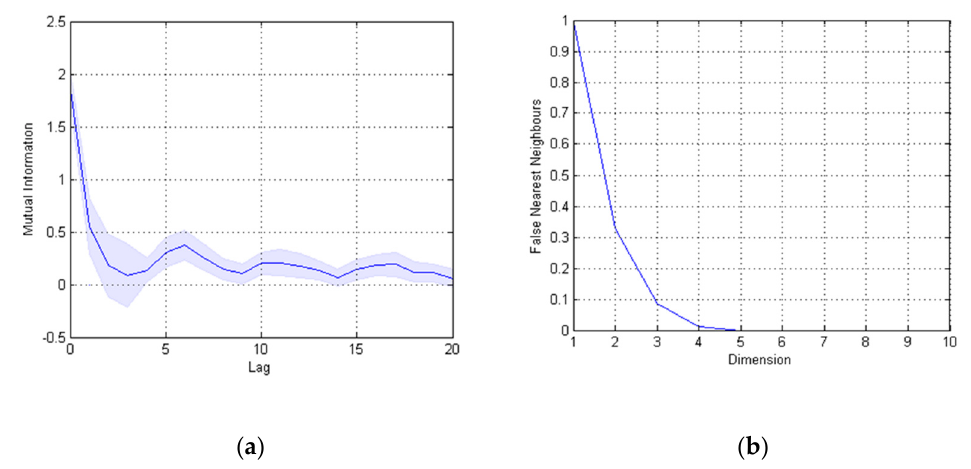
Figure 7. ( a ) The relationship between the mutual information value and the delay time (Lag). ( b ) The relationship between the ratio of false nearest neighbors and the value of embedded dimension.